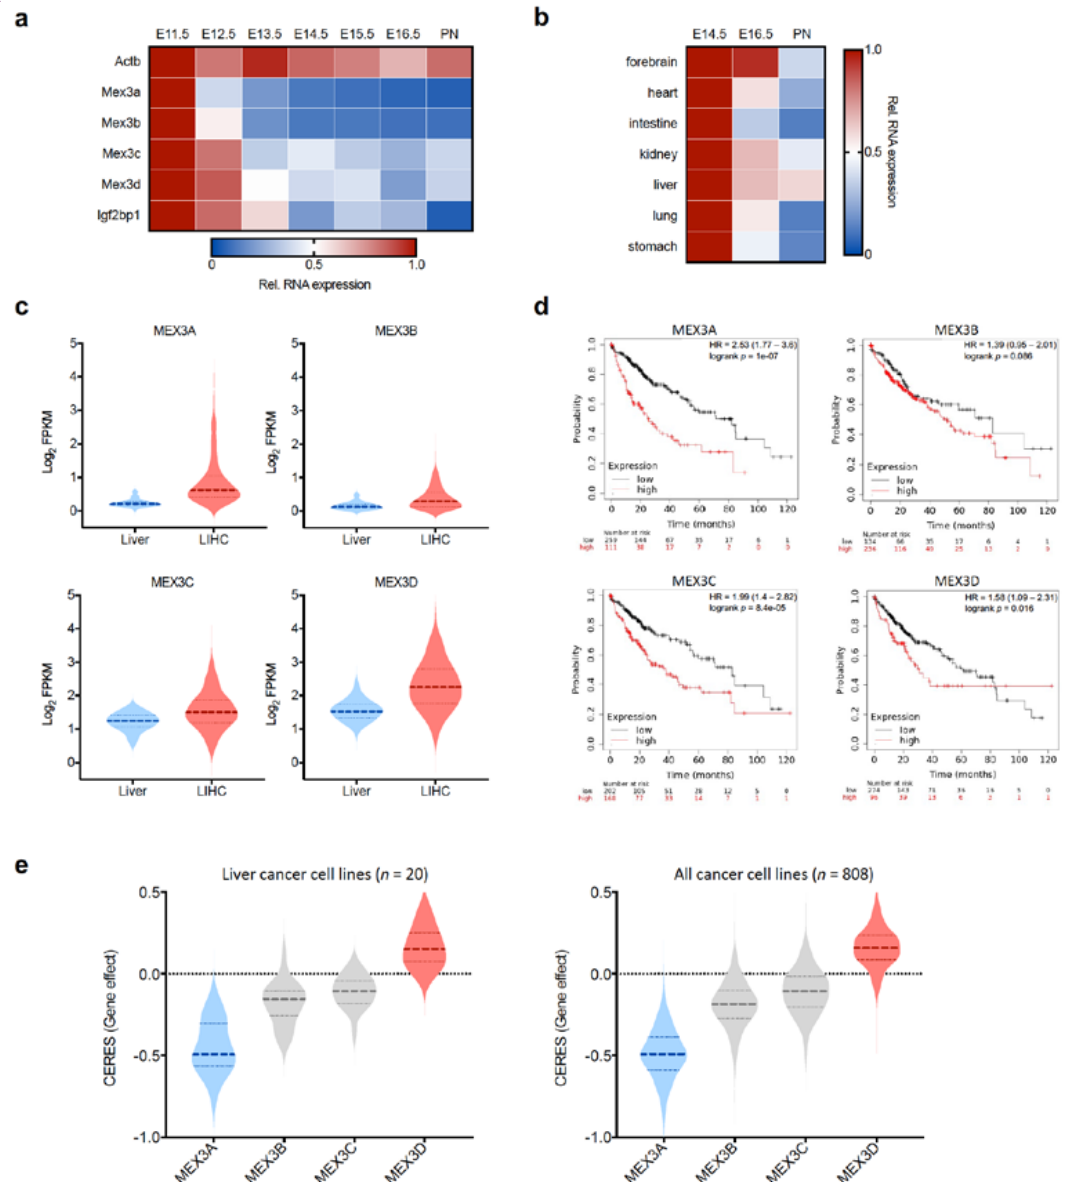
Figure 2. Oncofetal expression of MEX3 proteins. (a) The heat map shows the expression of the MEX3 mRNAs during mouse liver development. Actb and Igf2bp1 serve as controls. (b) The heat map depicts the expression of MEX3A mRNA during mouse development in various organs. (a) , (b) RNA seq expression data were obtained via the encode data portal (www.encodeproject.org; accessed on 12 March 2021) [44] . (c) Upregulation of human MEX3A-D mRNA expression in liver hepatocellular carcinoma (LIHC; n = 371; red) versus “normal” liver tissue (blue; n = 50) (transcriptome data provided by based on TCGA). (d) Survival analysis of MEX3 expression in liver hepatocellular carcinoma. The number of samples considered by kmplot (www.kmplot.com; accessed on 26 March 2021) [47] in the best cutoff and multivariate analyses are indicated. HR, hazard ratio. (e) . CERES corrected essentiality scores [48] of human MEX3 paralogs based on depmap portal data (www.depmap.org; Accessed on 26 March 2021) for liver cancer cell lines and cell lines from different cancer origins.